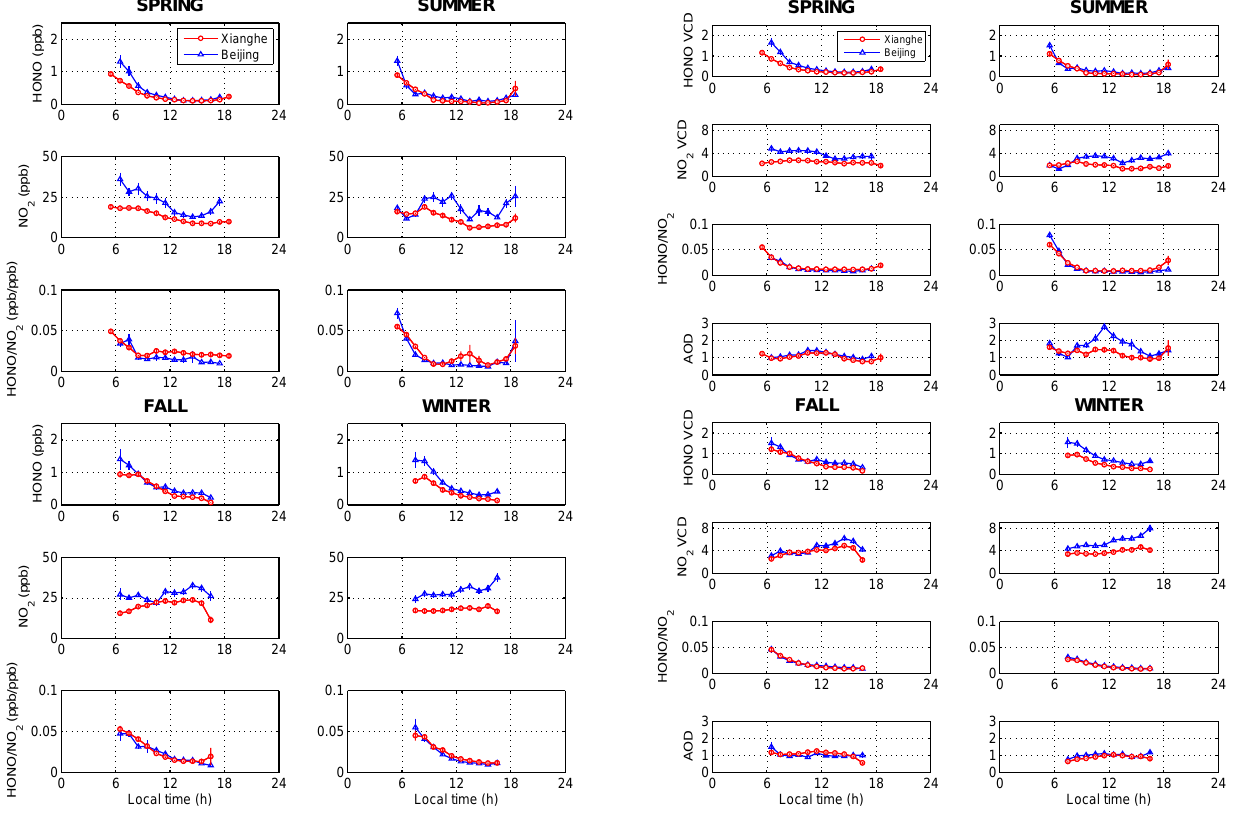
Fig. 11. Diurnal variation of the HONO and NO 2 concentrations (ppb) and their corresponding ratio in the 0–200m layer at Beijing (blue curves) and Xianghe (red curves). Data have been averaged per season using 1h bins. The error bars correspond to the standard deviation of the mean.